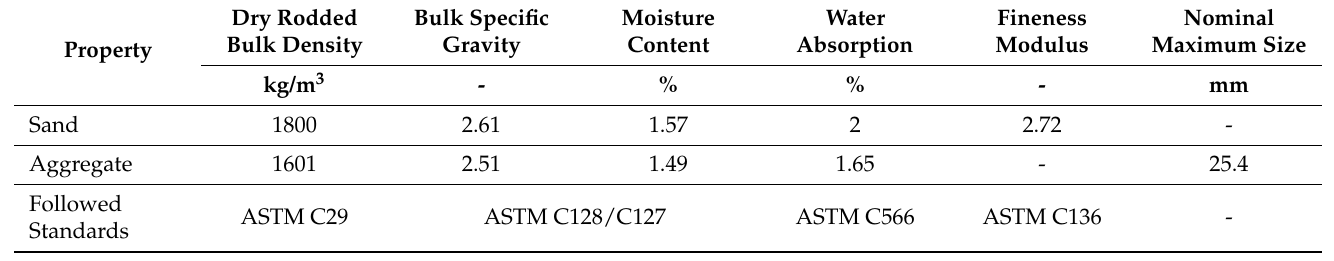
Table 3. Physical properties of sand and aggregates.